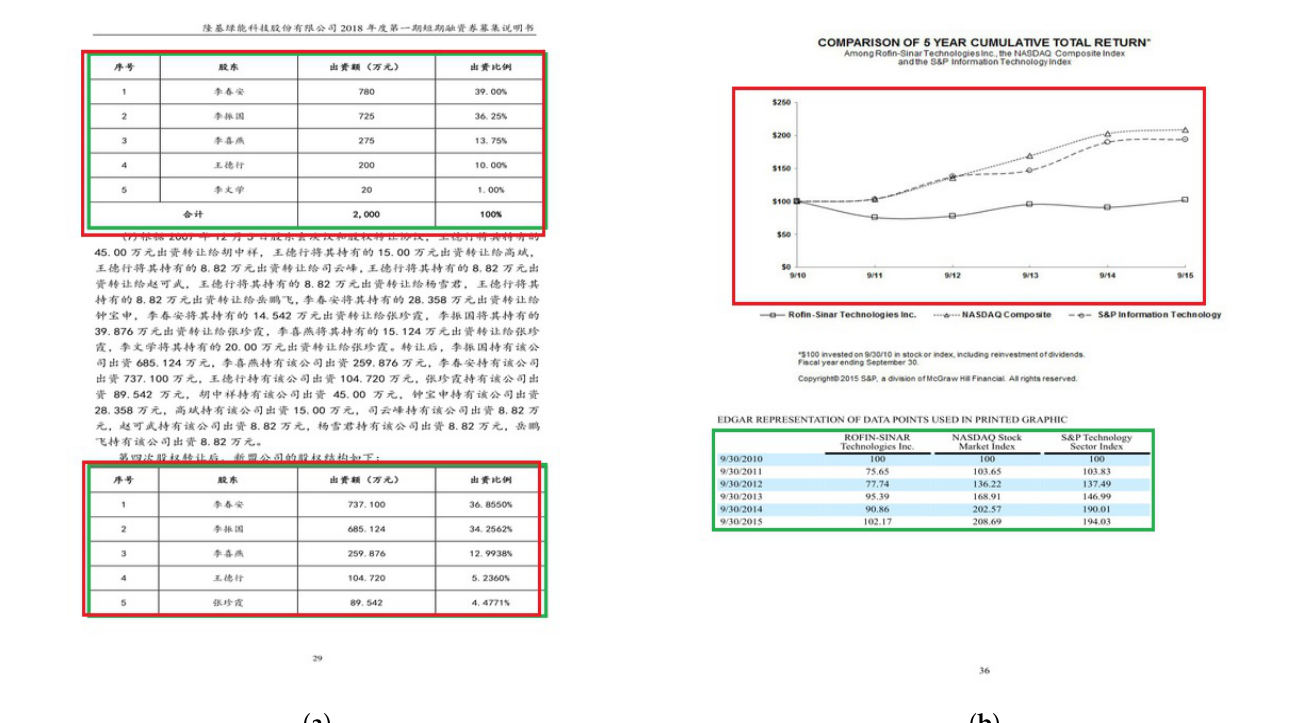
Figure 8. ROC curve for ICDAR 2019 dataset.